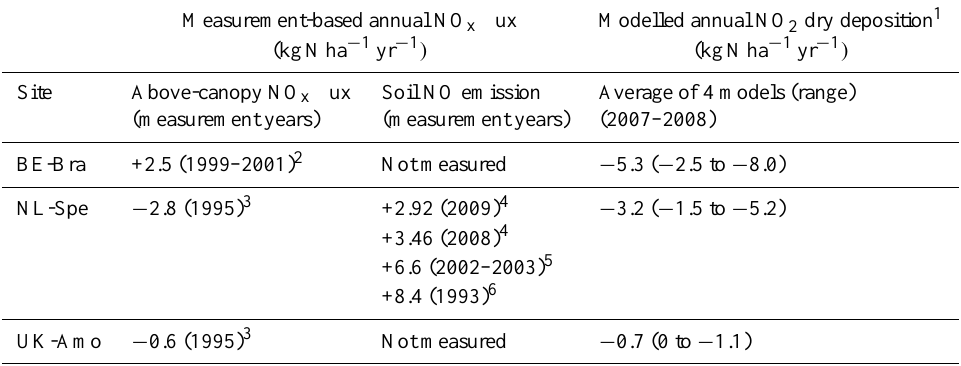
Table 4. Annual NO x exchange based on flux measurements at three NEU sites, and comparison with model results for NO 2